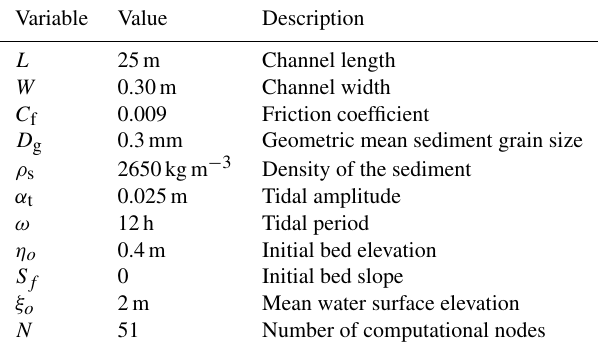
Table 1. Parameters for the shallow-water model.